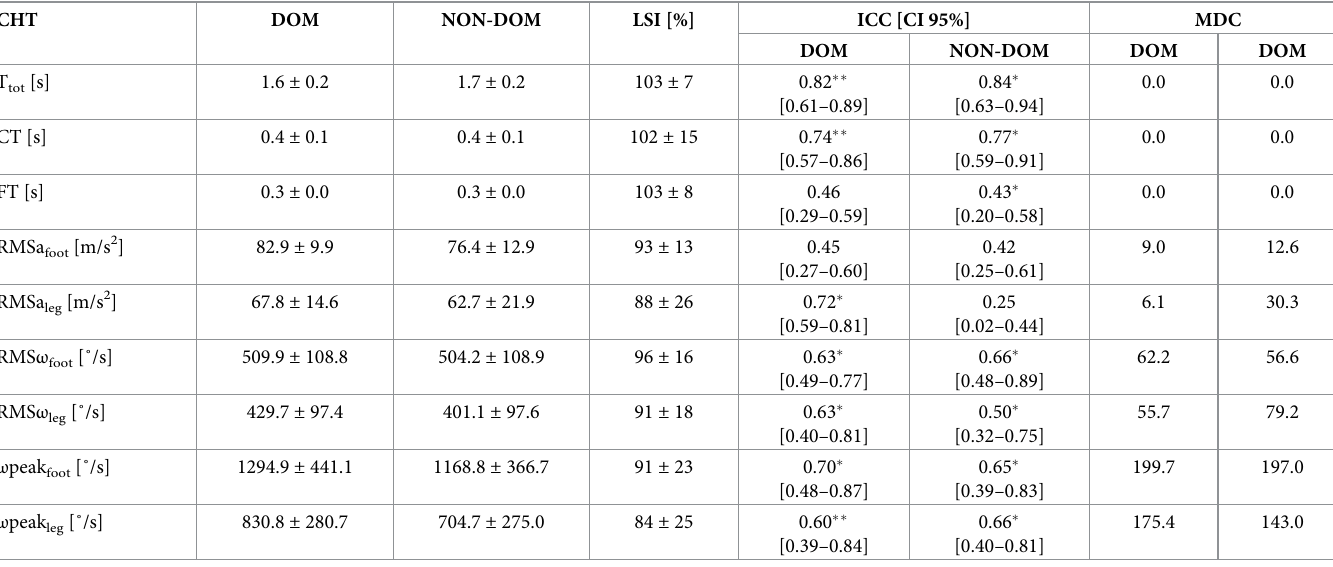
Table 4. Results of the parameters estimated during the CHT (mean ± standard deviation).